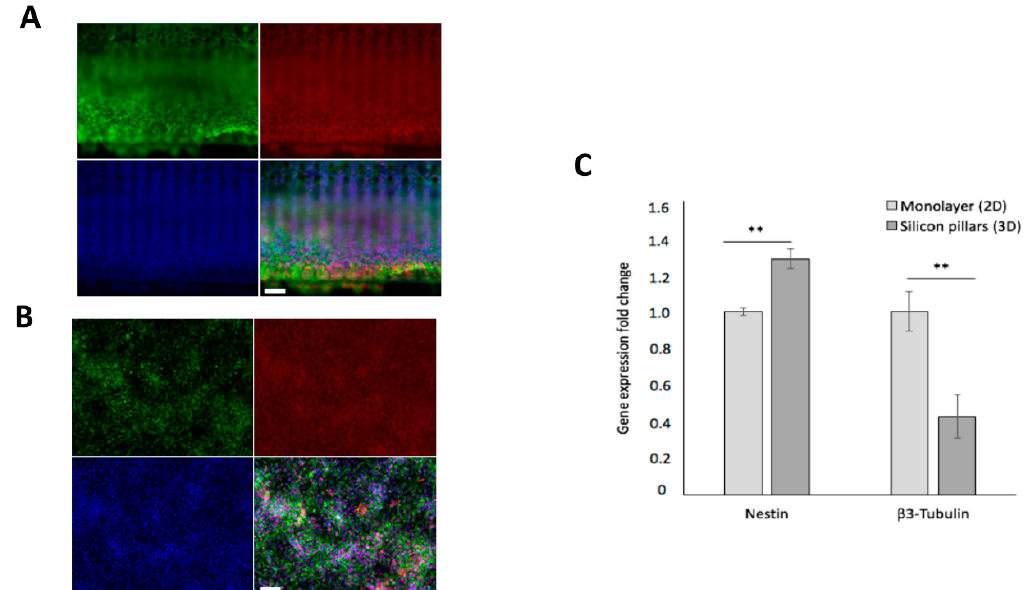
Figure 7. hCPs seeded on silicon slide maintain their neural immature identity. Immunostaining of hCPs for NESTIN (green), SOX2 (red) and nuclear staining with Hoechst (blue) in 3D culture ( A ) and 2D culture ( B ) cultured for 14 days. ( C ) Quantitative RT-PCR assay showing the expression levels of Nestin and β 3-Tubulin transcripts in hCPs grown in 2D or 3D cultures. Scale bar: 100 µm ( A ) and 50 µm ( B ). p < 0.01 (**), not significant (ns).